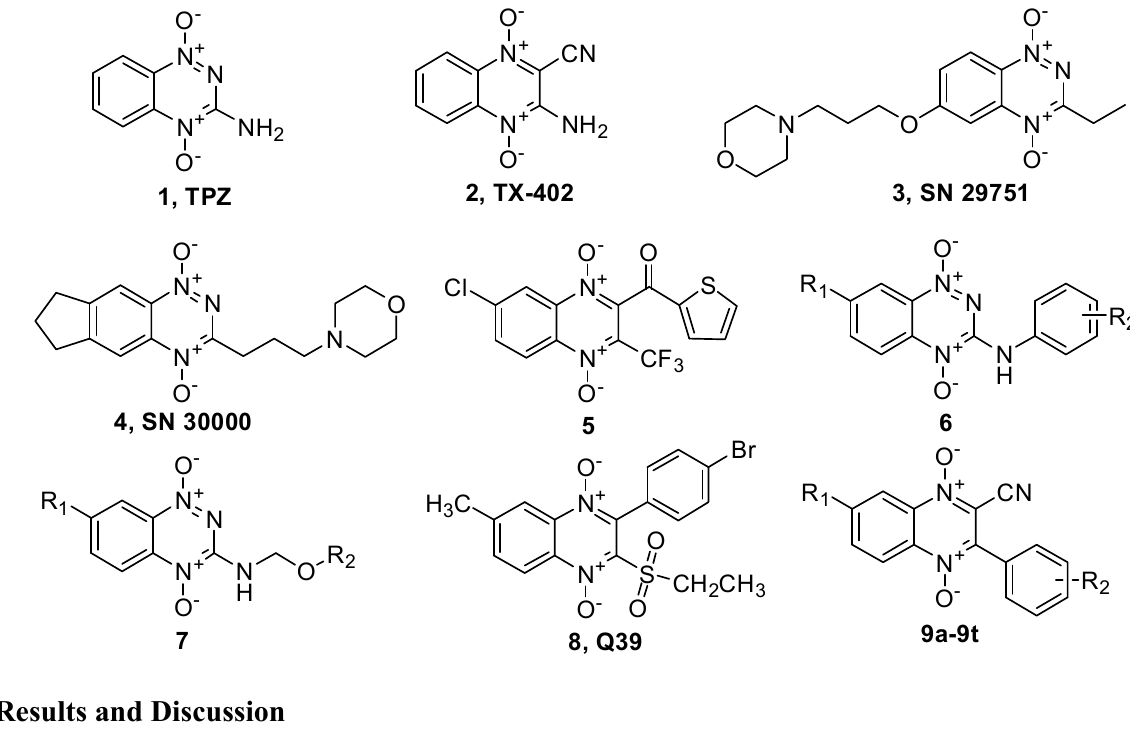
Figure 1. The structures of aromatic N -oxides with hypoxic cytotoxic